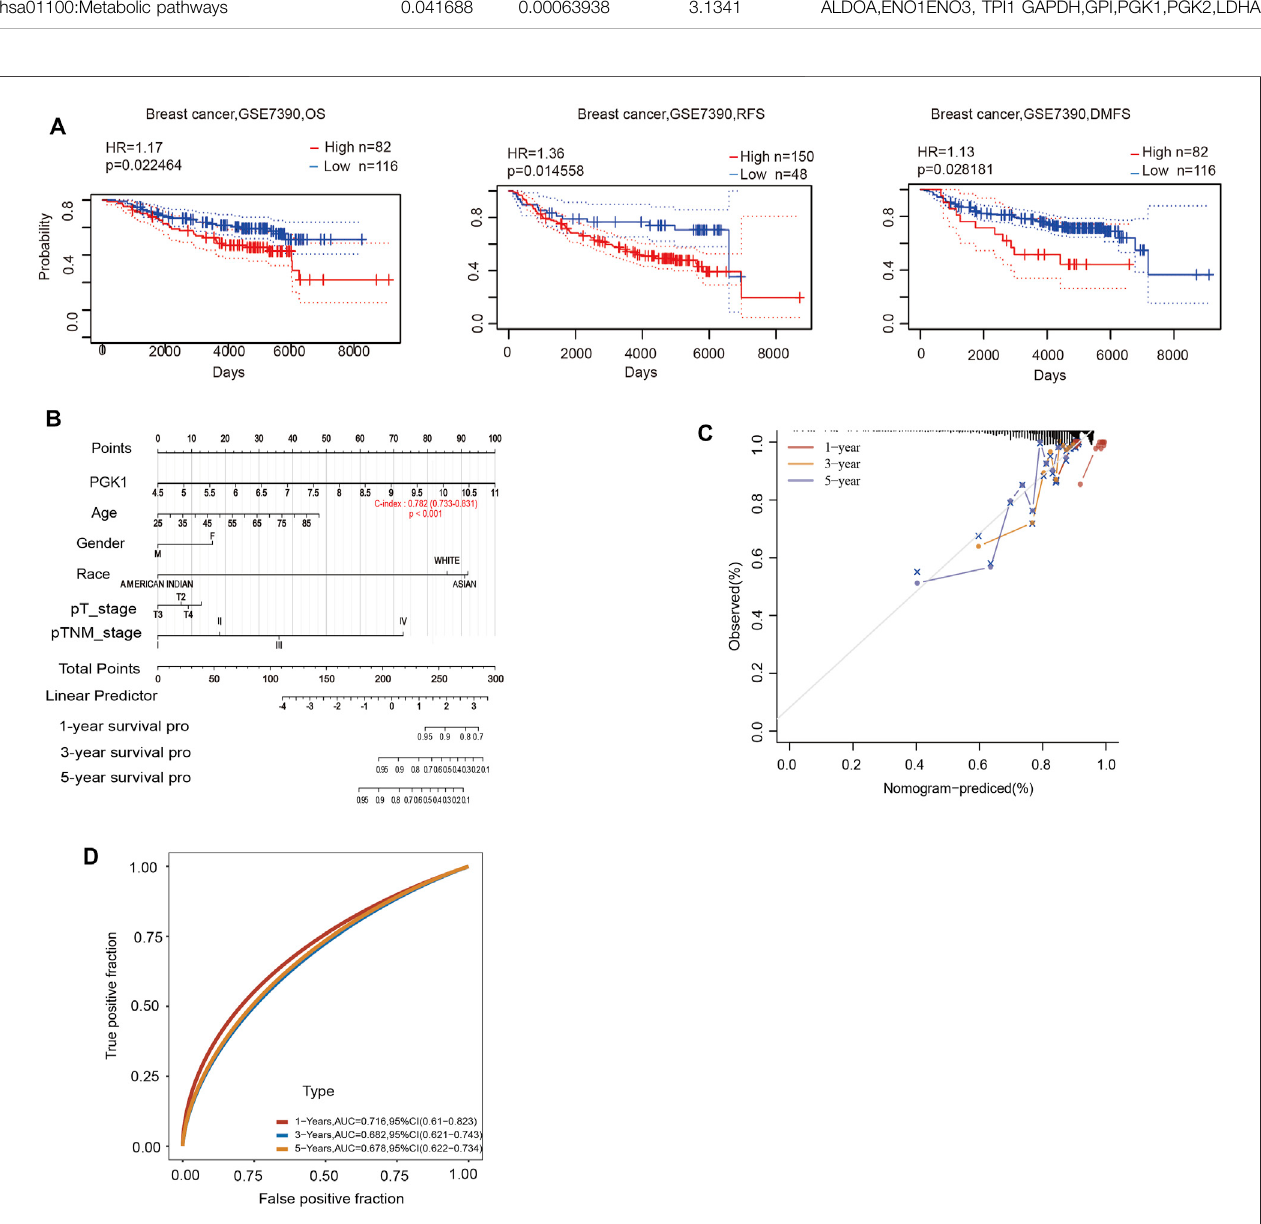
FIGURE8|(A) Prognosticsigni fi canceofPGK1geneexpressioninpatientswithbreastcancer(OS,RFSandDMFStimeinthePrognoScandatabase).OS,overallsurvival;RFS, relapse-free survival; DMFS, distant metastasis free survival; HR, hazard ratio. (B) Nomogram to predict the 1-year, 3-years, and 5-years overall survival of breast cancer patients. (C) Calibrationcurvefortheoverallsurvivalnomogrammodelinthebreastcancergroup.Adasheddiagonallinerepresentstheidealnomogram,andtheredline,orangeline,andblueline represent the 1-year,3-years, and 5-years observed nomograms. (D) Time-dependent ROC analysis the of the fi ve-gene signature. ROC, receiver operating characteristic.